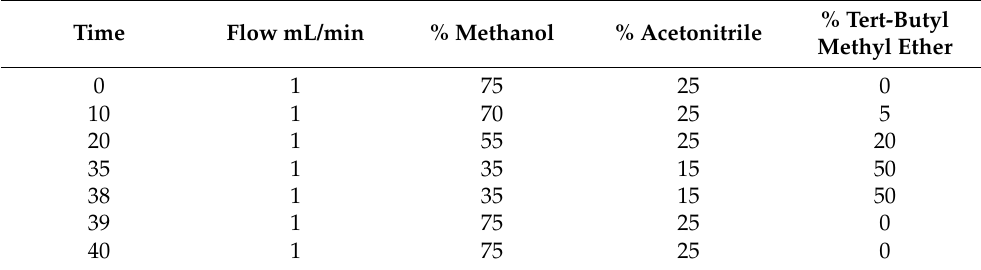
Table 4. Gradient solvents for tocopherol chromatography